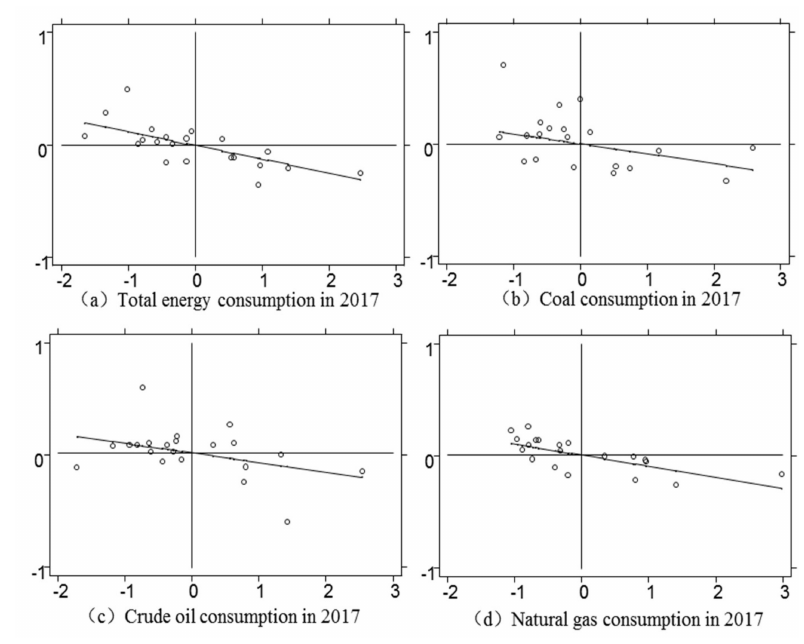
Figure 2. 2017 local Moran